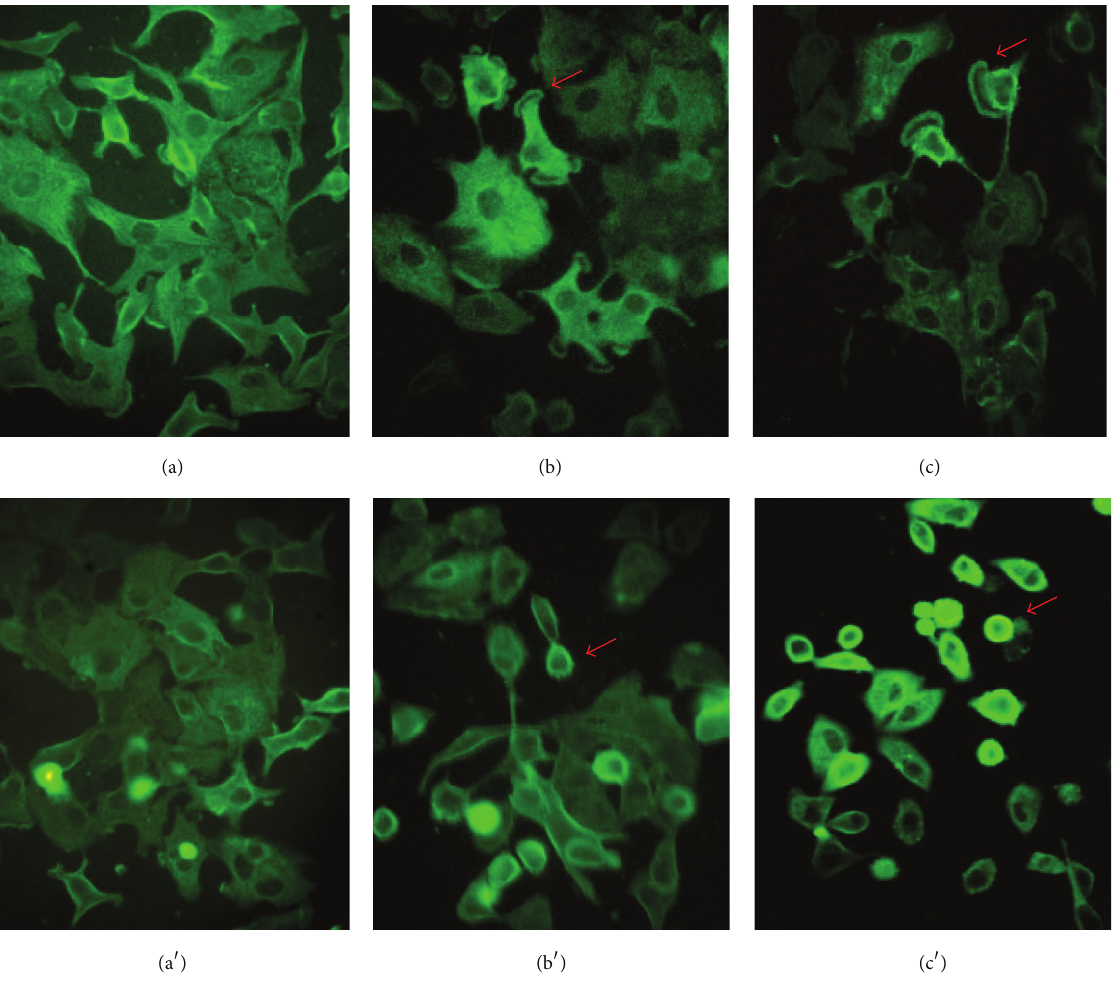
Figure 5: Microtubules of cells exposed to SeMet and SSe. Controls (a and a 󸀠 ); cells treated with 0.5 and 1.5 mM Se as SeMet (b and c) and SSe (b 󸀠 , c 󸀠 ) for 48 h. Arrows show changes in microtubule distribution and loss of